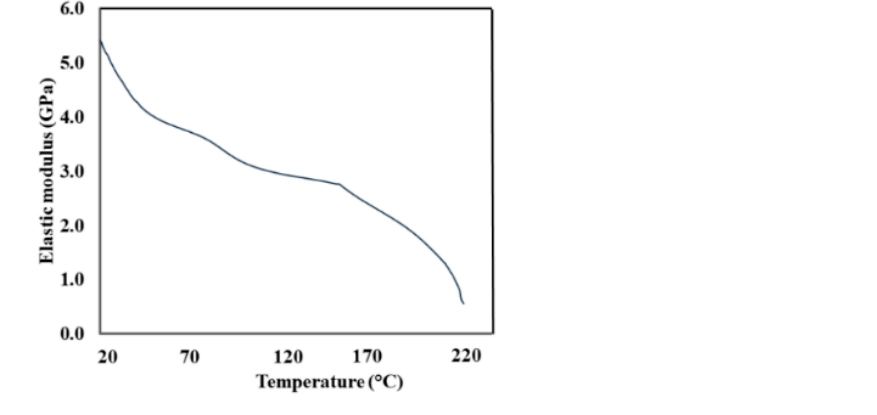
Figure 5. Variation in elastic modulus of polyamide 6 as a function of temperature. Table 5. Stress coefficient for CFRP at different strain rates and Table 4. Hensel–Spittel model constants for Al-5754.